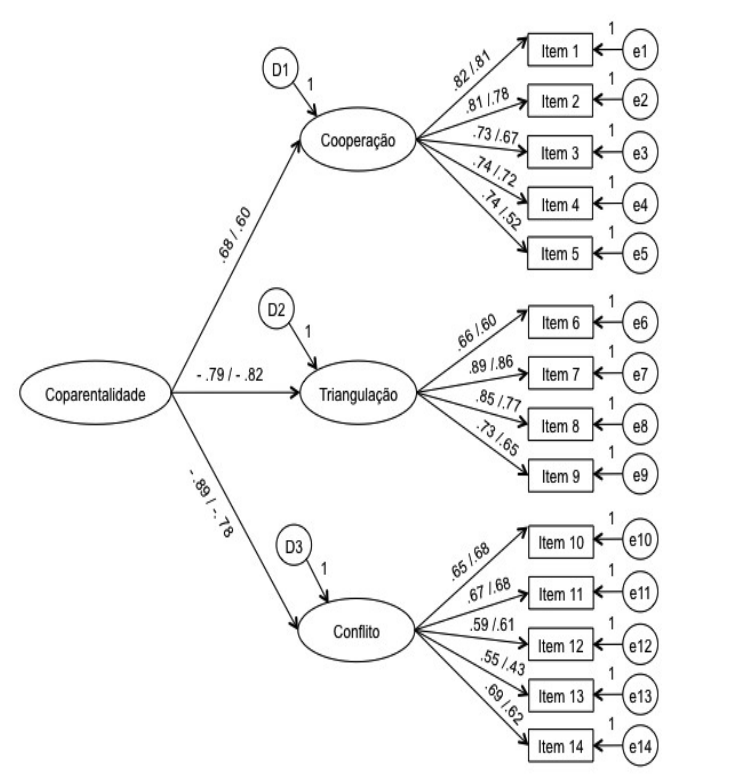
Figura 1 . Modelo 1 - Modelo hierárquico como proposto por Margolin et al. (2001) para pais e mães. Os primeiros coe fi cientes são referentes às mães e os segundos coe fi cientes são referentes aos